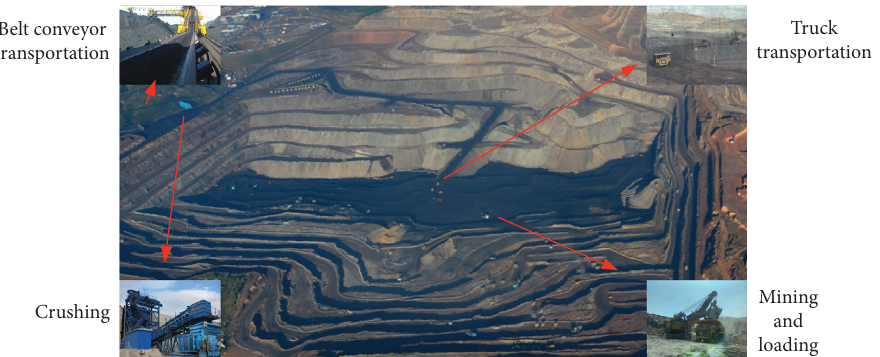
Figure 3: Schematic diagram of spatial layout of the coal mining semicontinuous process